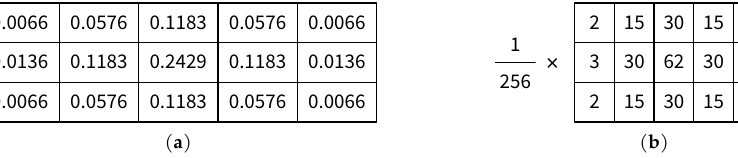
Figure 23. Coefficients of 3 × 5 Gaussian kernel in Section 3.1: ( a ) original; and ( b ) integer